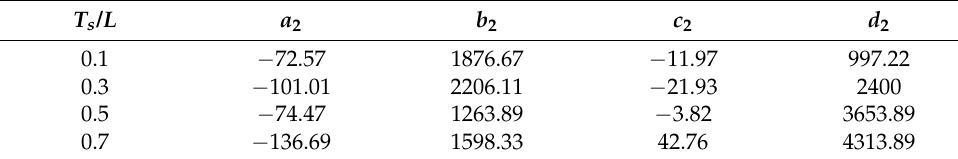
Table 4. Values of parameters related to T s / L in Equation (4) ( v 0